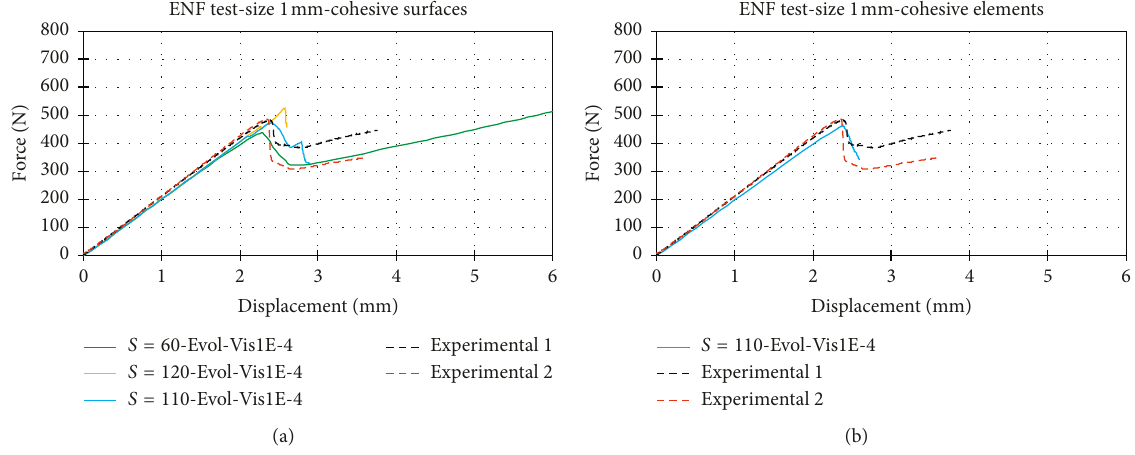
Figure 25: ENF test: cohesive elements and surfaces (element size 1mm).